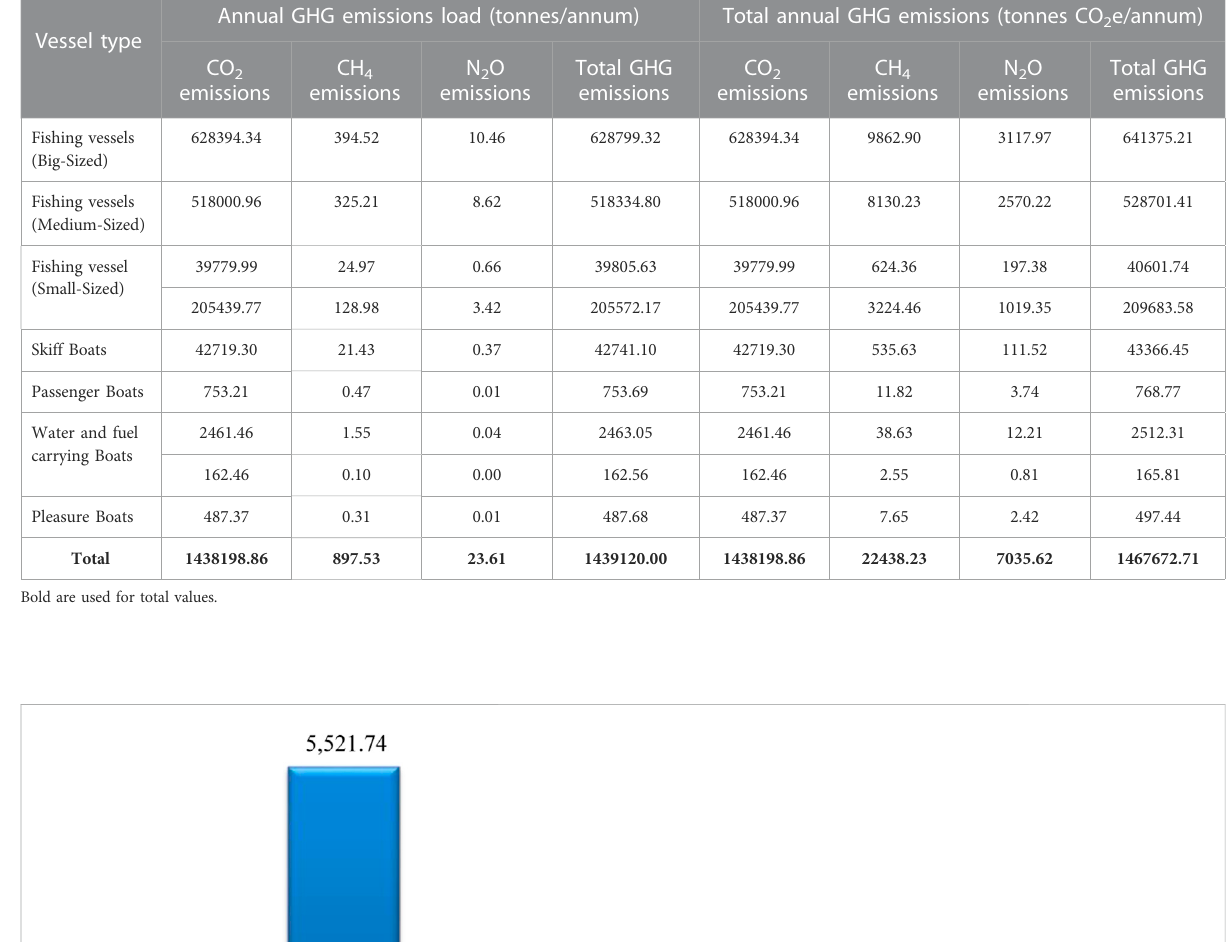
TABLE 13 Breakdown of GHG Emissions from Fishing and other crafts in Sindh, Pakistan.